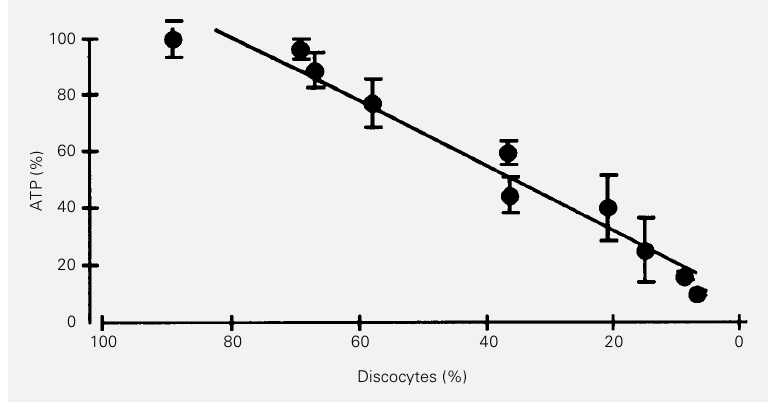
Figure 2 - Correlation between ATP concentration and percent of discocytes in blood preserved in ADSOL for 12 weeks. Data are reported as means ± SD for 10 samples. One hundred percent ATP corresponds to 4.5 ± 0.3 µmol ATP/g hemoglobin. The circles represent the experimental data, and the full line was calculated using the best fit